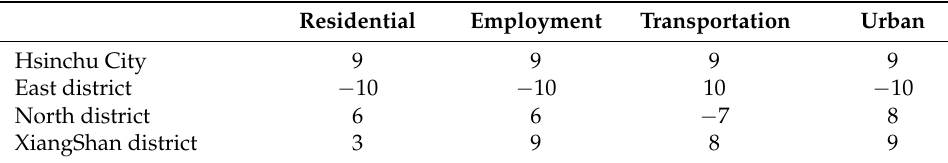
Table 6. Time lags (in years) for Hsinchu City and its associated